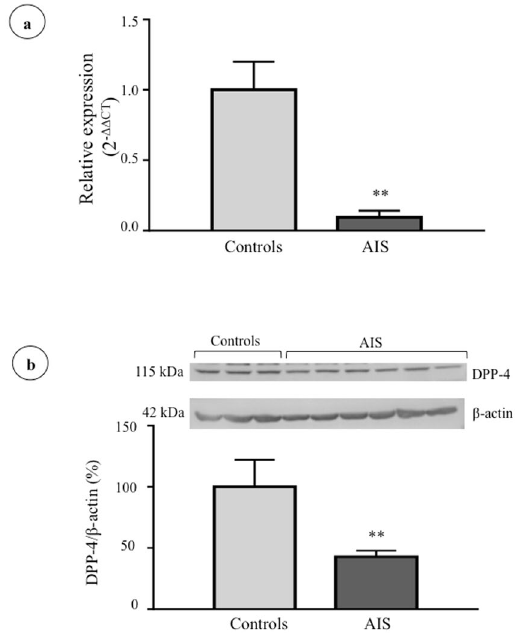
Figure 2. DPP-4 gene and protein expression in osteoblasts isolated from controls and AIS patients. ( a ) DPP4 gene expression was measured by RT-qPCR with GAPDH as endogenous control (n = 7/group). Relative expression was analyzed with the 2 −ΔΔ CT method. ( b ) DPP-4 protein expression was evaluated by Western blot (n = 3 controls and n = 6 AIS patients) and β -actin was used as endogenous control. ** P < 0.01 using two-tailed Student’s t-test. Data are presented as mean ± standard